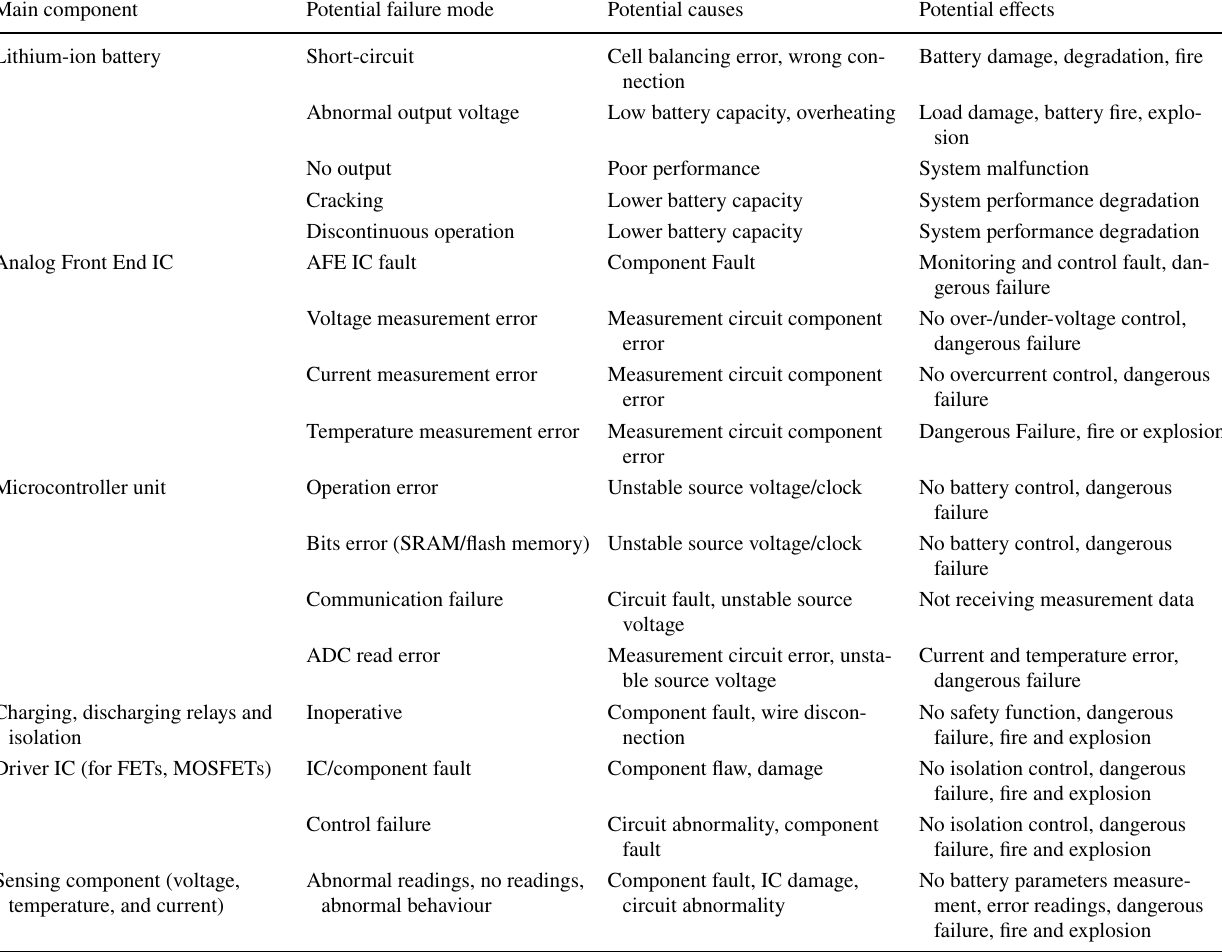
Table 6 Basic FMEDA analysis for corresponding BMS major